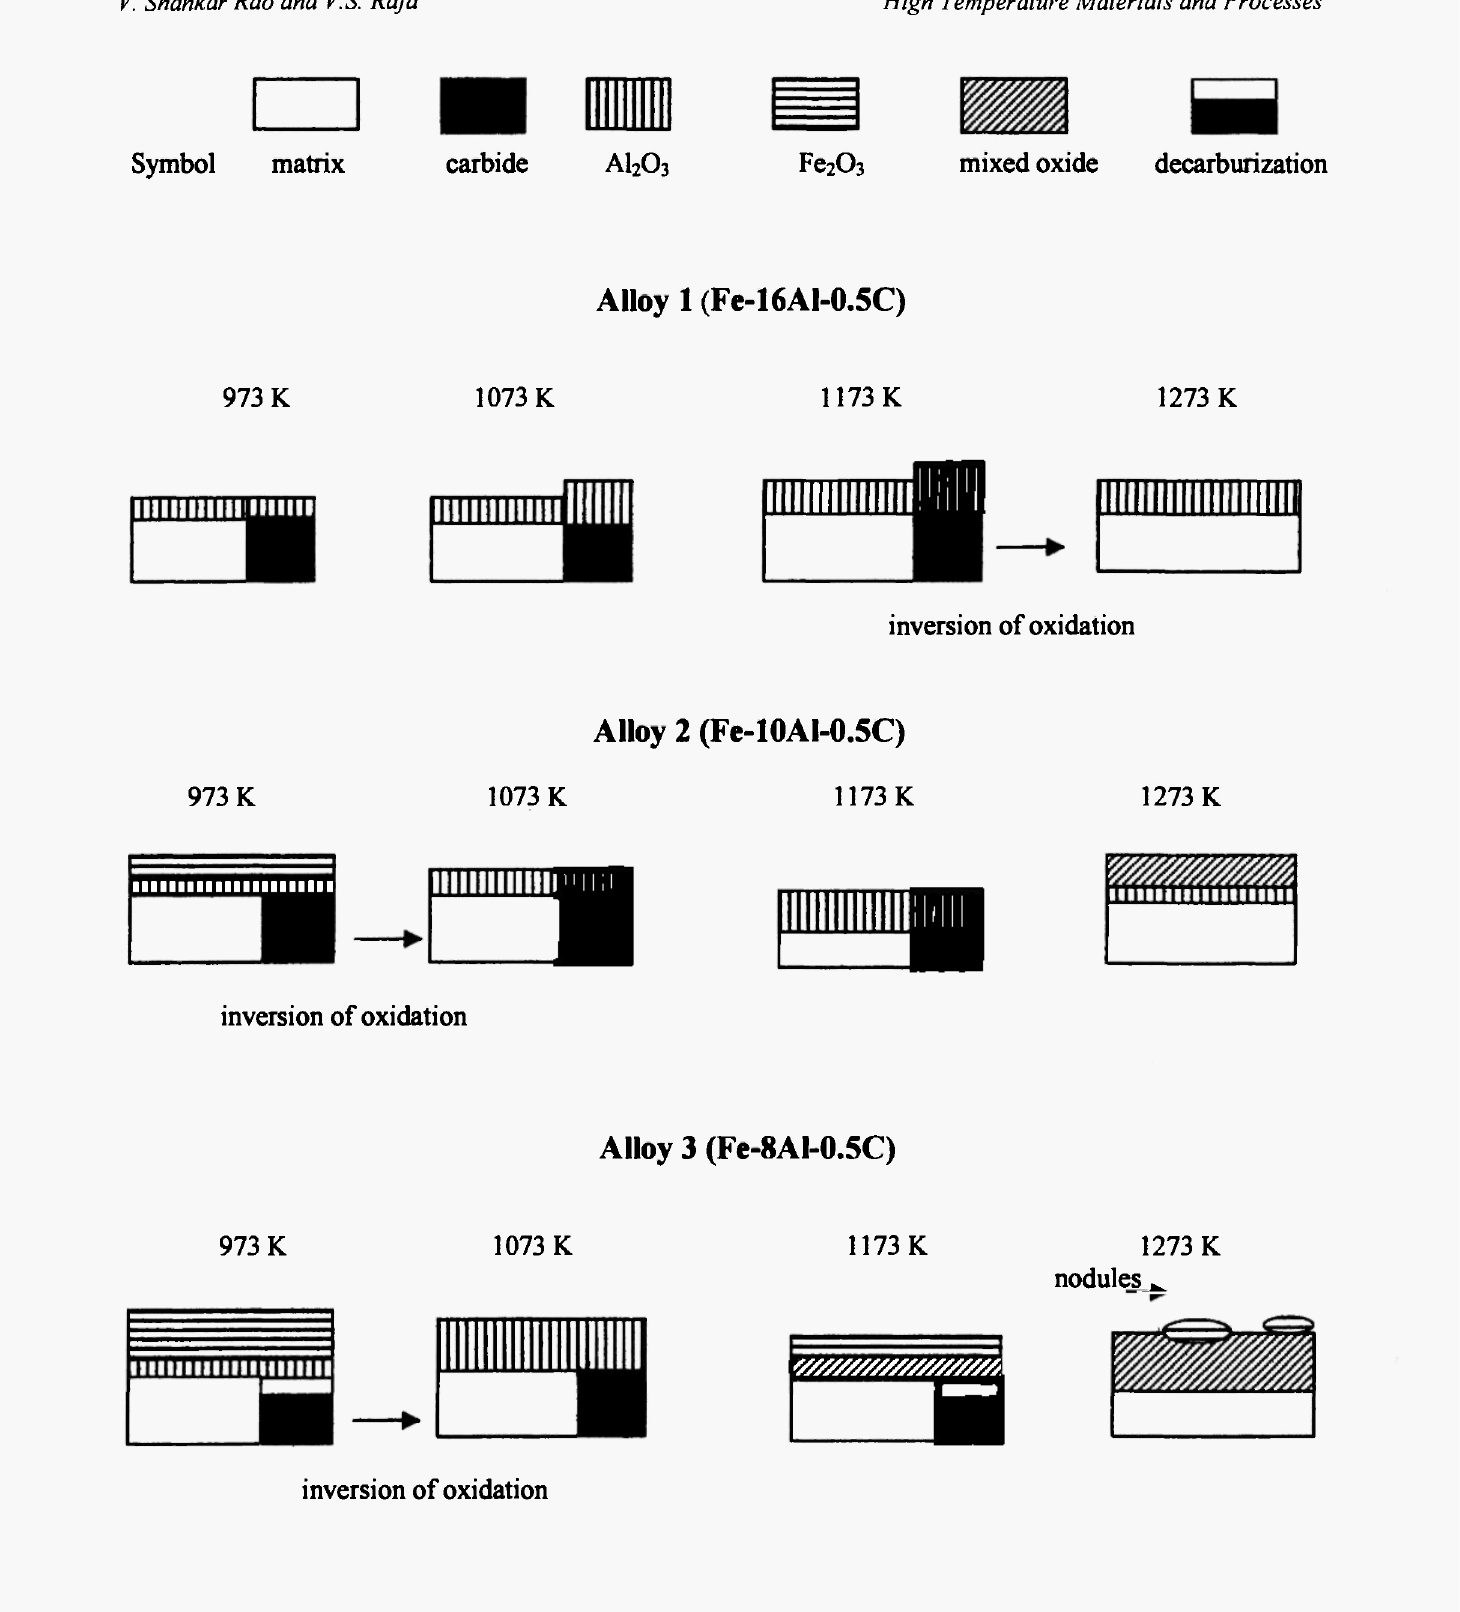
Fig. 11 : Schematic diagram of the oxidation of Fe-Al-C